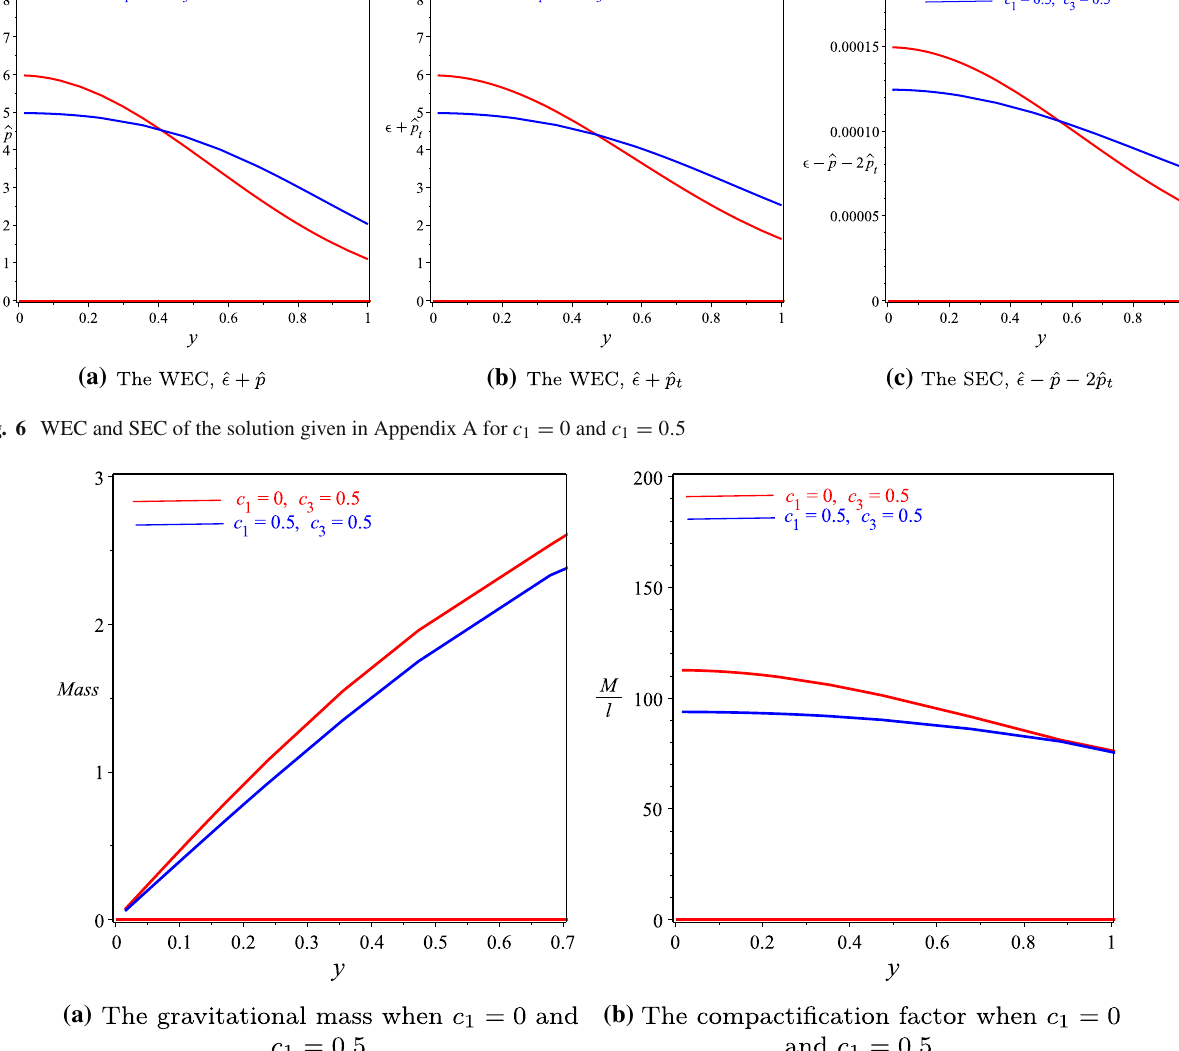
Fig. 7 The gravitational mass and compactification factor of solution given in Appendix A for c 1 = 0 and c 1 = 0 .